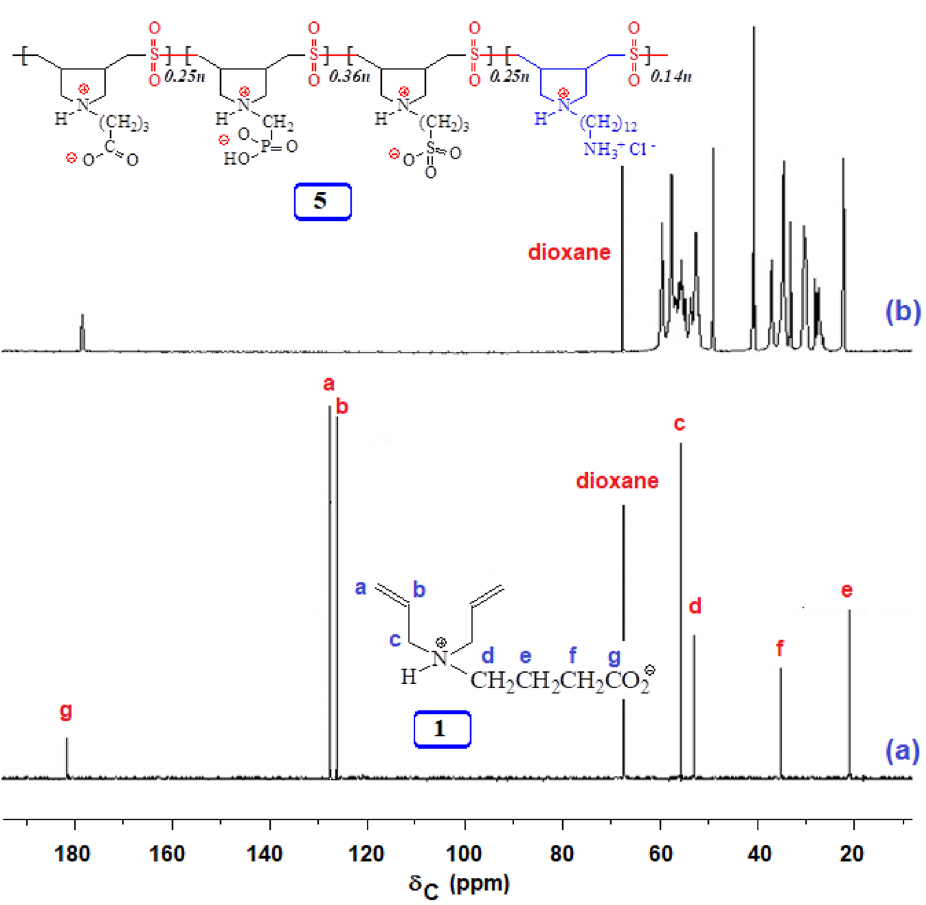
Figure 2. 13 C NMR spectra of (a ) monomer 1 in D 2 O and ( b ) PP 5 in 3.5 M KBr in D 2